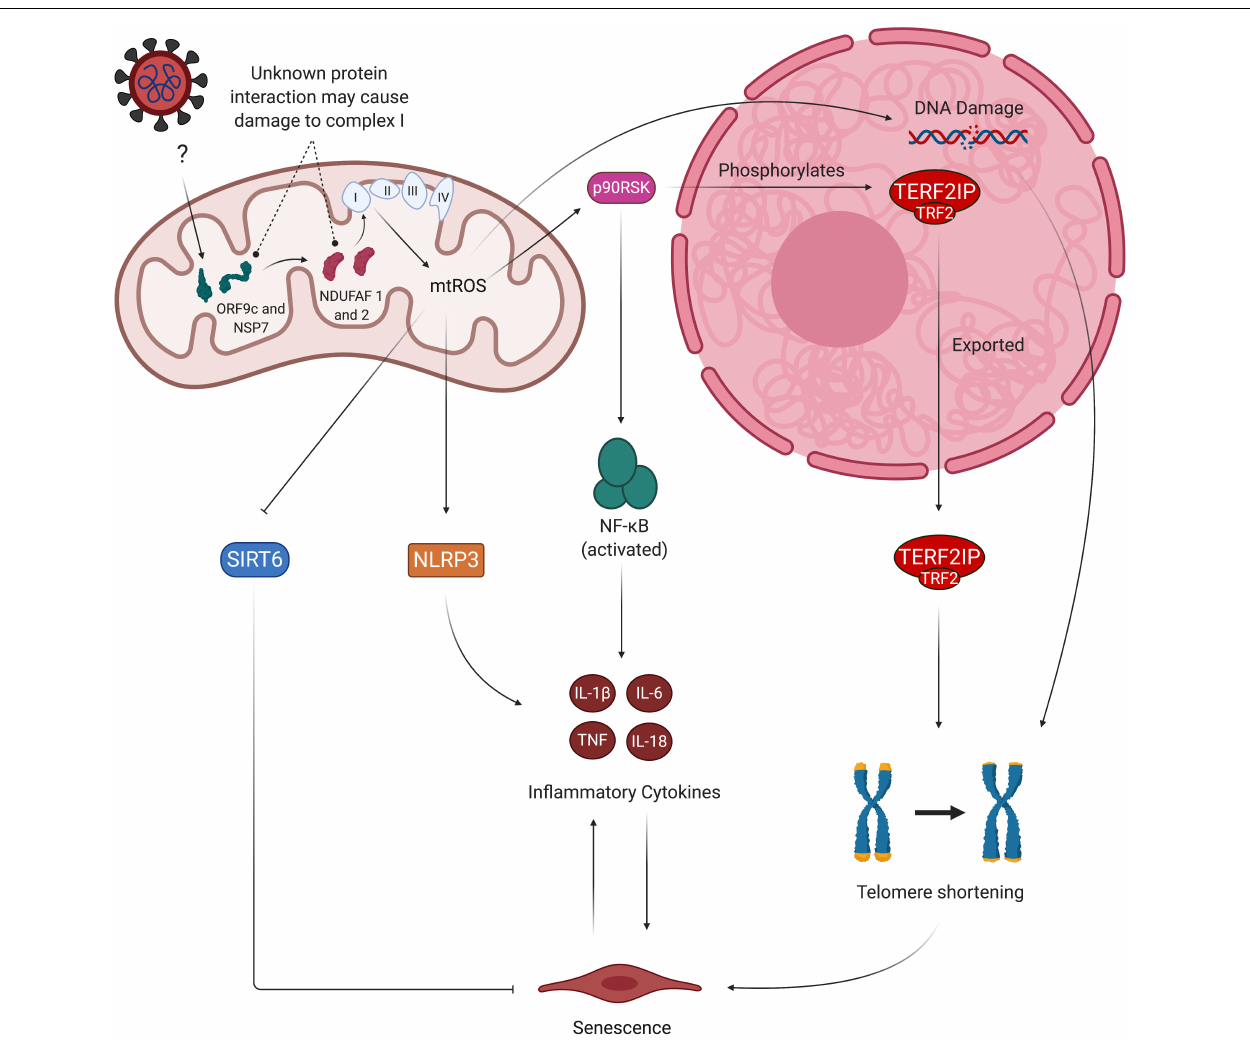
FIGURE 5 | Viral hijacking of mitochondria may result in pro-senescent mitochondrial dysfunction and inflammation. Studies show evidence of viral proteins (ORF9c and NSP7) interacting with mitochondrial proteins (NDUFAF 1 and 2). While the exact nature of this interaction is unknown, NDUFAF 1 and 2’s roles in assembly of the ETC suggest the interaction may dysregulate proper formation of the ETC’s complexes, thus leading to increased mtROS production. mtROS-mediated activation of p90RSk then results in attenuation of anti-senescent SIRT6 and phosphorylation of TERF2IP, which is exported from the nucleus along with TRF2. This causes telomere shortening and subsequent induction of senescence and SASP. Other factors contributing to SASP include oxidative activation of NLRP3 inflammasome and NF-kB signaling mediated by the TERF2IP-TRF2 complex. Senescent ECs experience greater sensitivity to oxidative stress due to decreased activity of eNOS and secretion of inflammatory cytokines, thus perpetuating the cycle of oxidative stress and inflammatory SASP. mtROS, mitochondrial reactive oxygen species; eNOS, endothelial nitric oxide synthase; ORF9c, open reading frame 9c; NSP7, non-structural protein 7; p90RSK, 90 kDa ribosomal protein S6 kinase 1 (p90RSK); NF-kB, nuclear factor kappa beta; NLRP3, NLR family pyrin domain containing 3; TERF2IP, telomeric repeat-binding factor 2-interacting protein; TRF2, telomeric repeat-binding factor 2; SIRT6, sirtuin